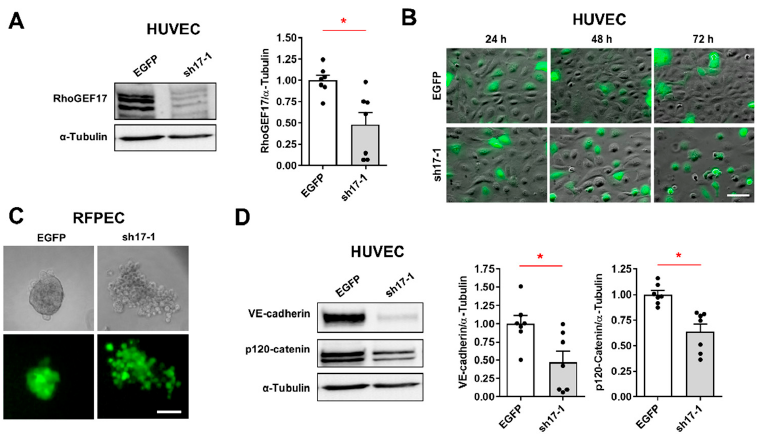
Figure 1. RhoGEF17 is essential for cell-cell contacts and adherens junctions (AJ) protein regulation in EC. ( A , B , D ) Human umbilical vein endothelial cells (HUVEC) were transduced with adenoviruses encoding EGFP alone (EGFP) or in addition to a shRNA against RhoGEF17 (sh17-1). ( A ) After 48 h, RhoGEF17 was detected in cell lysates. Shown are representative immunoblots of RhoGEF17 and α -tubulin and the quantitative analysis. Values are normalized and given as means + SEM with the single data points, n = 7, * p < 0.05 analyzed by paired t-testing. ( B ). Depicted are bright field/EGFP overlay images of transduced HUVEC. Scale bar = 100 µ m. ( C ) Rat fat pad endothelial cells (RFPEC) were transduced for 48 h and then used to generate spheroids. Bright field and fluorescence images are shown. Scale bar = 200 µ m. ( D ) VE-cadherin, p120-catenin, and α -tubulin were detected by immunoblot in lysates of transduced HUVEC. Shown are representative immunoblots and the quantified data normalized by α -tubulin and relative to EGFP as means + SEM with the single data points, n = 4 − 7, * p < 0.05 analyzed by paired